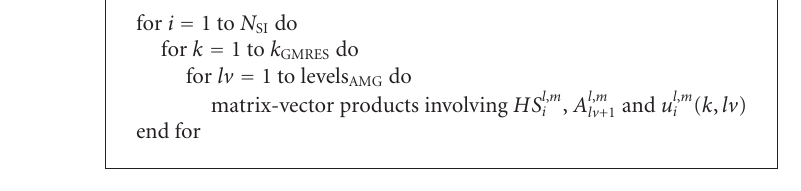
Algorithm 2: Sketch of Algorithm SI.